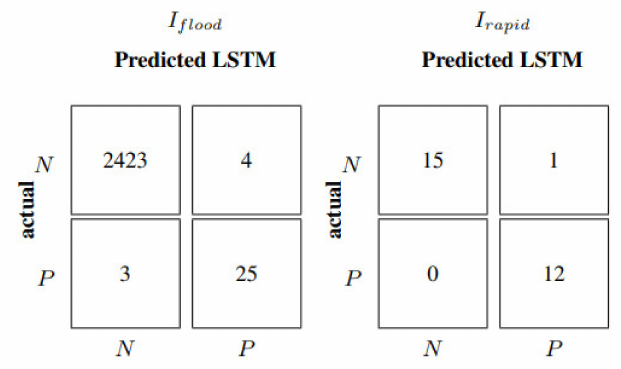
Figure 13. I flood and I rapid for the LSTM model with 10-min input update frequency. Laveggio test data, rain gauges scenario. P means a flood or a rapid event is present, N means that it is not.